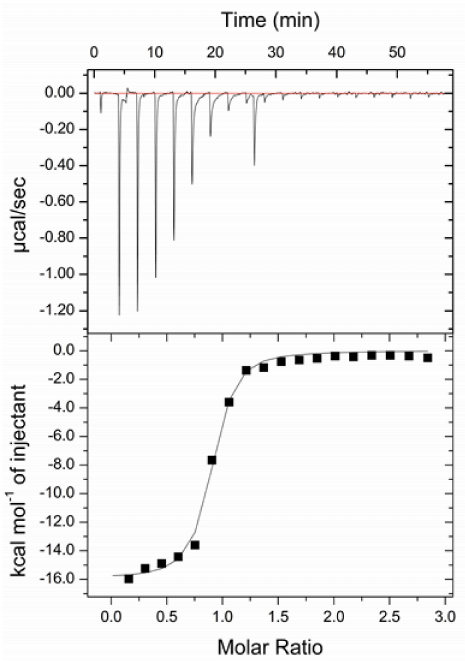
Figure 5. ITC heat signature (top panel) and the corresponding binding curve (bottom panel) when Oligo1* (30 µ M) is titrated with BSA (300 µ M). The solid line in the bottom panel is a guide to the